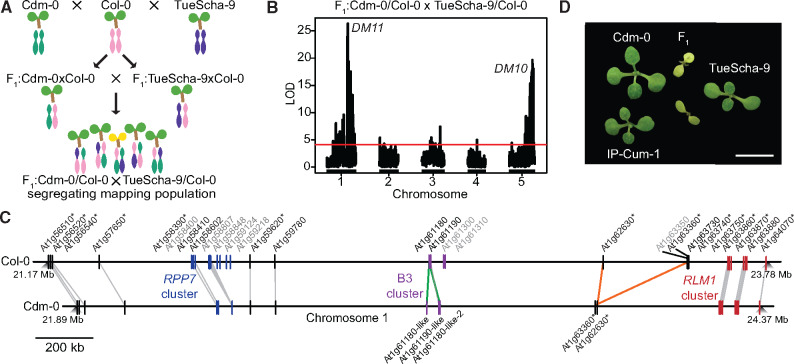
QTL mapping with a triple-hybrid cross. (A) Creation of a Cdm-0×TueScha-9 mapping population. (B) QTL analysis from polymorphic Cdm-0 and TueScha-9 markers. QTL peaks are found on chromosome 5 (23.35–24.45 Mb), DM10, and chromosome 1 (21.55–22.18 Mb), DM11. The horizontal lines indicate 0.05 significance threshold established with 1,000 permutations. (C) Comparison and distribution of candidate DM11 NLR genes between At1g56510 and At1g64070 on chromosome 1. Gene IDs in gray are present in Col-0 but not in Cdm-0, gene duplications are marked in green and inversion events in orange. Asterisks indicate significant (|log2FoldChange|>1, Padj value <0.01) gene expression changes in the F1 hybrid when compared with the MPV. (D) Cdm-0×TueScha-9 and IP-Cum-1×TueScha-9 hybrids. Plants are 2 weeks old and were grown at 16 °C. Scale bar represents 1 cm.